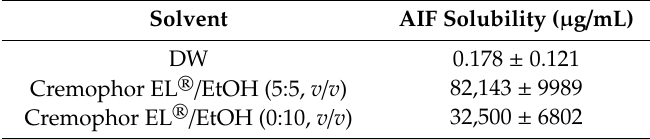
Table 1. Solubility of alpinumisoflavone (AIF) dissolved in water and Cremophor EL ® / EtOH.